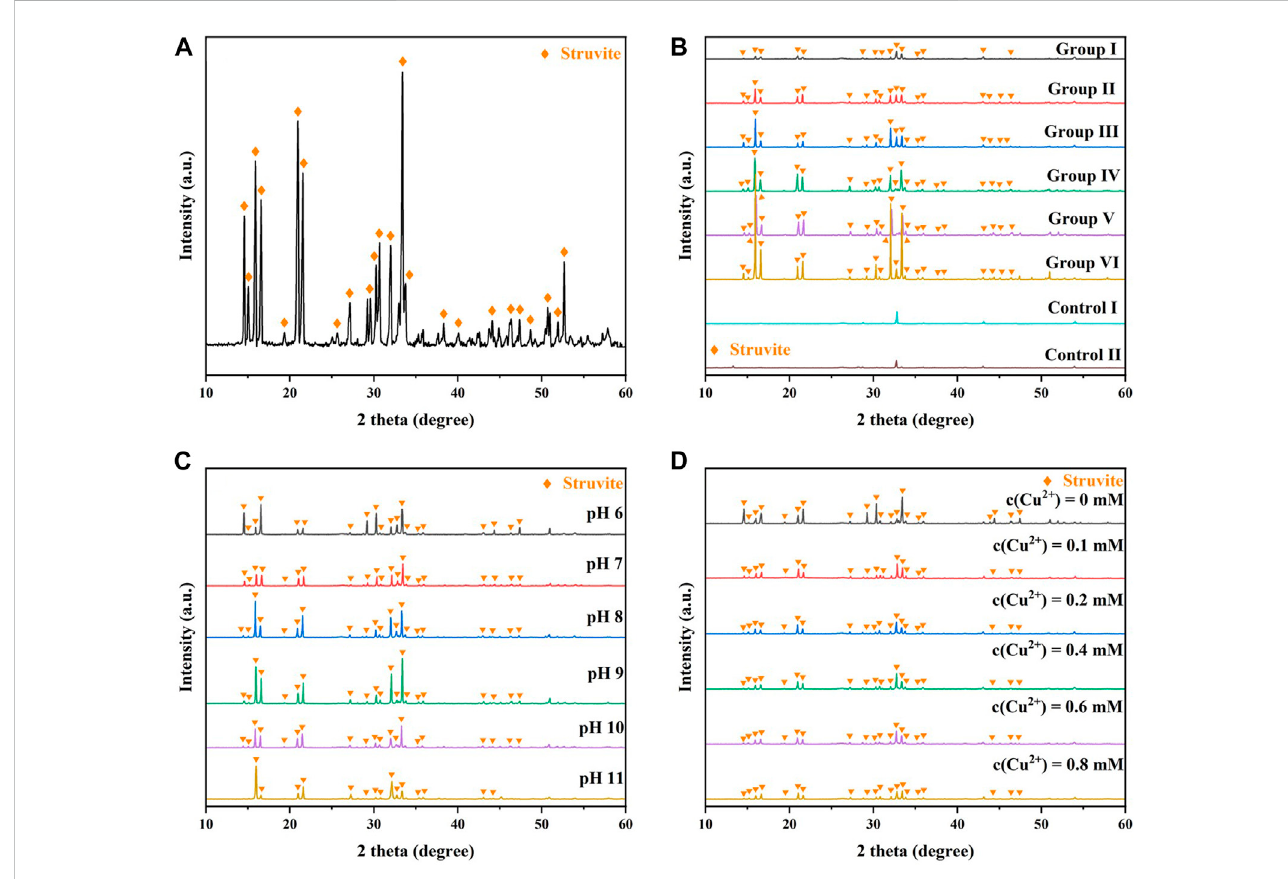
FIGURE 9 (A) XRD patterns of MAP and XRD patterns of precipitates for (B) different groups, (C) different pH values, and (D) different concentrations of Cu 2 +